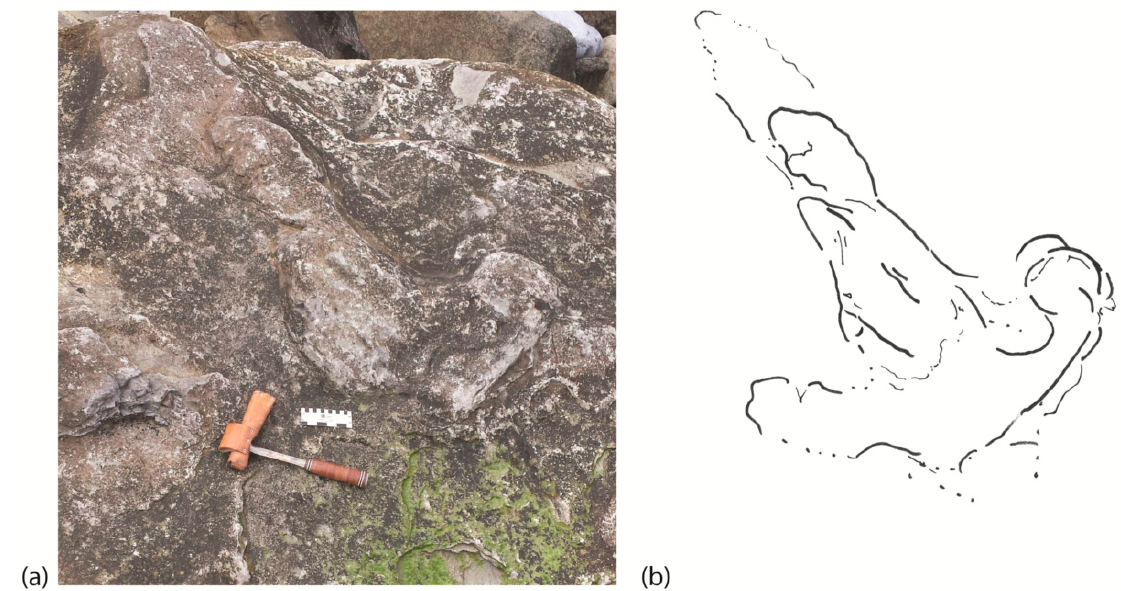
Figure 6. Large theropod footprint from the Valtos Sandstone Formation near Dùn Dearg, Trotternish Peninsula, Isle of Skye, ( a ) field photograph (not collected from the Dùn Dearg rockfall); ( b ) diagramatic interpretation of footprint. Scale card = 13 cm.